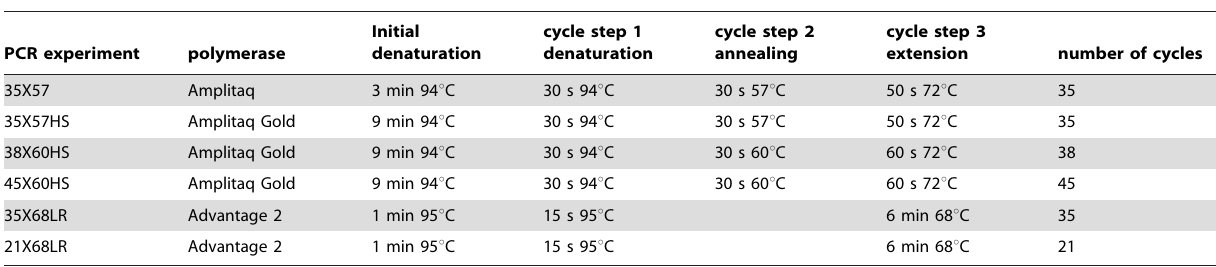
Table 3. PCR conditions for different